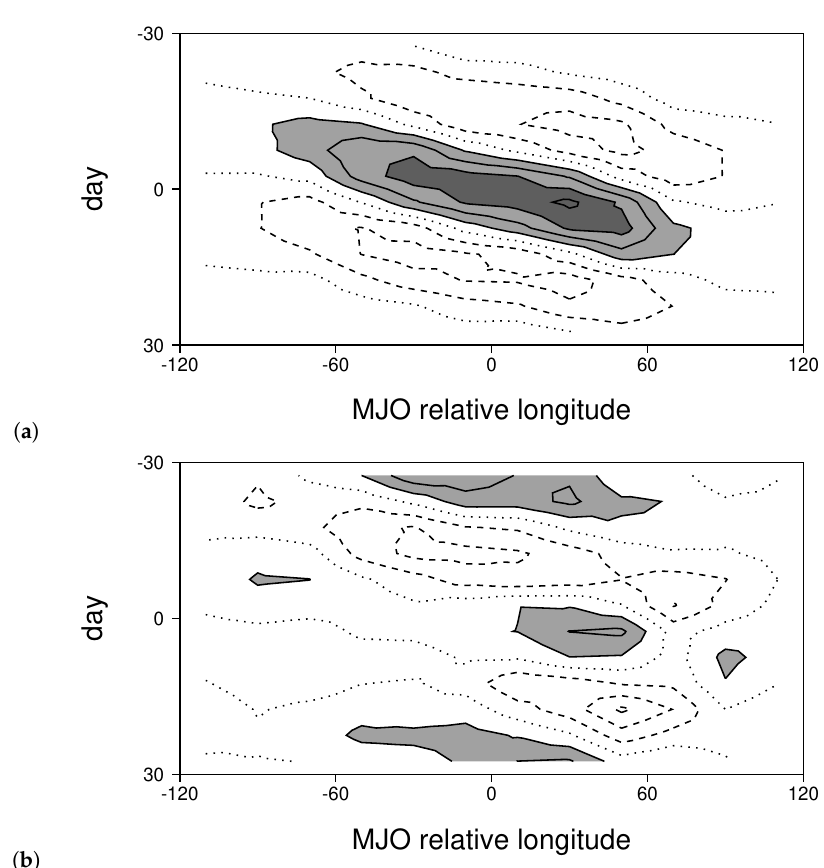
Figure 9. Change in MJO composite rainfall time series during the simulation. ( a ) Composite MJO rainfall for Years 71–100 (contoured as in Figure 5a). ( b ) Difference between the composite rainfall for Years 71–100 and that for Years 1–30 (0.2 mm/day contour interval, values greater than 0.2 mm/day shaded light